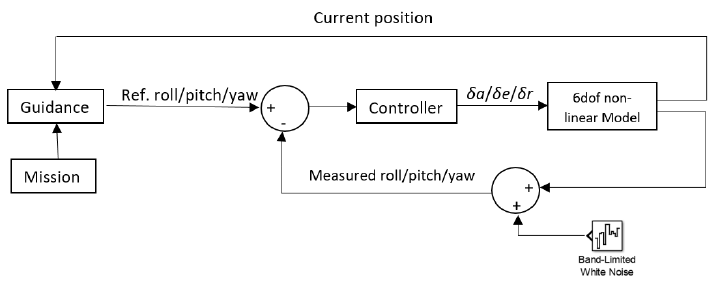
Figure 16. Block diagram of current control system and implementation of noise.